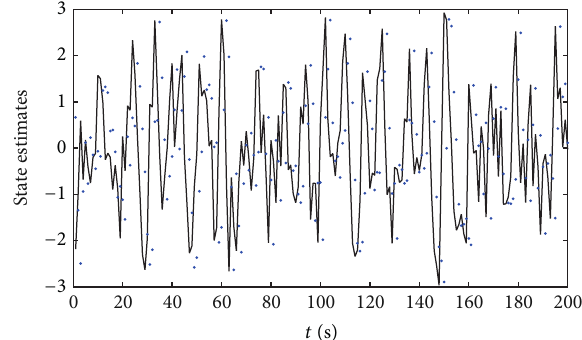
Figure 3: The state estimation errors 𝛿 versus 𝑡 ( 𝜎 2 = 0.20 2 ). Solid line: the true 𝑥 2 (𝑡) ; dots: the estimated ̂𝑥 2 (𝑡)